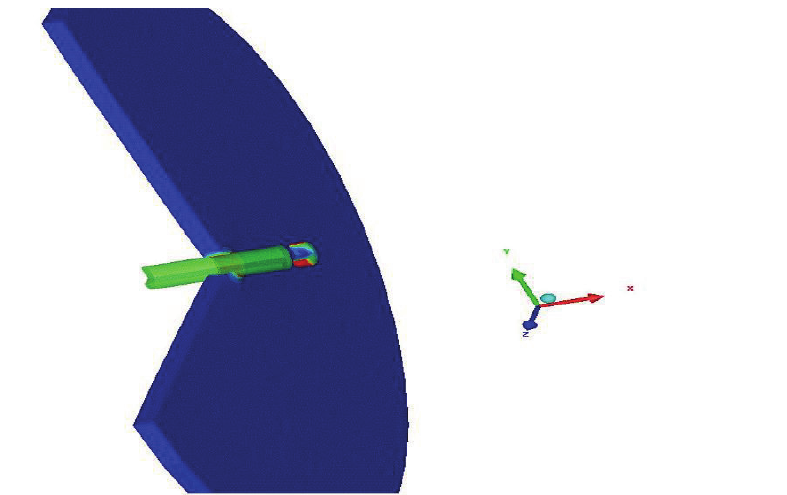
Figure 19 – 3D Flat Perforation of a steel shell with a blunt projectile (FEM Method) Рис . 19 – Изображение 3 Д перфорации стальной плиты тупоконечным снарядом